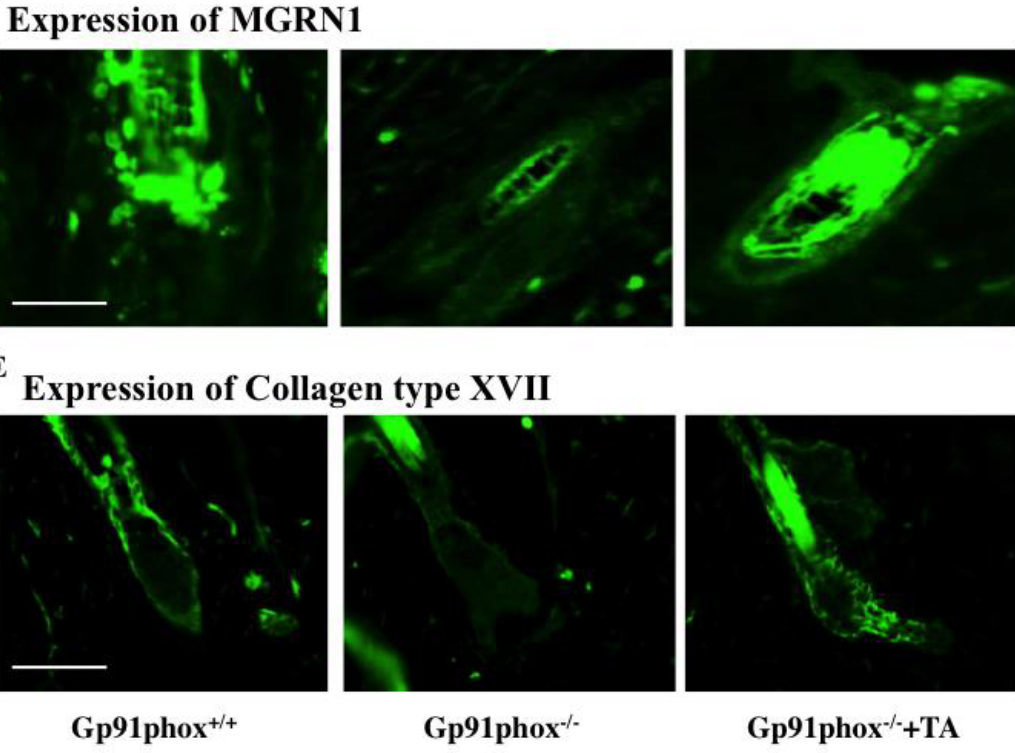
Figure 3. The effect of tranexamic acid on the hair color ( A ) and the effect of tranexamic acid on the expression of MC1R ( B ), ASIP ( C ), MGRN1 ( D ), and collagen XVII ( E ) in the twelve-month-old gp91phox −/− mice. The data show the results from one typical experiment involving six animals. Scale bar = 10 μm.